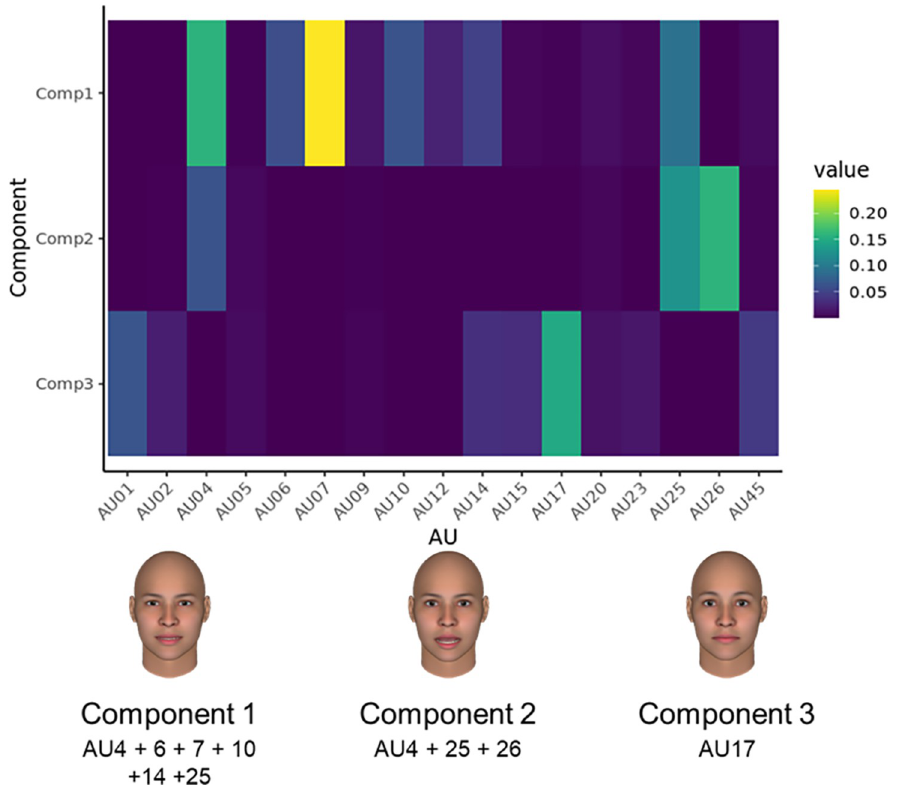
Fig 4. Heatmap of each component’s loadings for facial expressions of anger (upper part) and visual representations (lower part). Value colors represent each facial movement’s contribution to component scores.